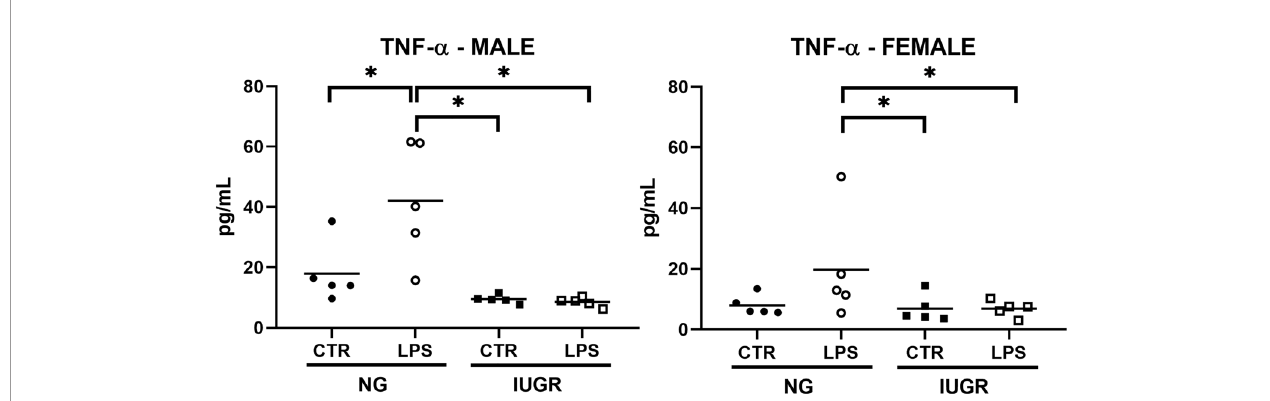
FIGURE 5 | Intra-uterine growth restriction (IUGR) attenuates the hepatic TNF- a protein levels in the LPS-exposed newborn. IUGR and normally grown (NG) male and female neonatal (P0) livers were collected and measured for hepatic TNF- a (pg/mL) protein levels at 1-hour post IP LPS by ELISA. * P <0.05 by 2-way ANOVA (IUGR and LPS as factors), and Fisher ’ s LSD Post-hoc test. Values are represented